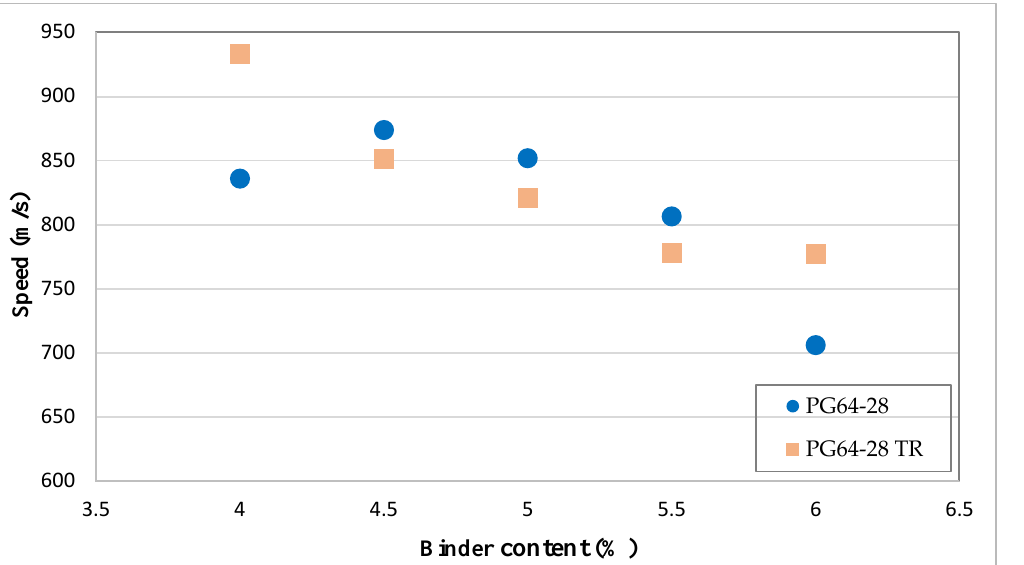
Table 3. Optimum binder content.